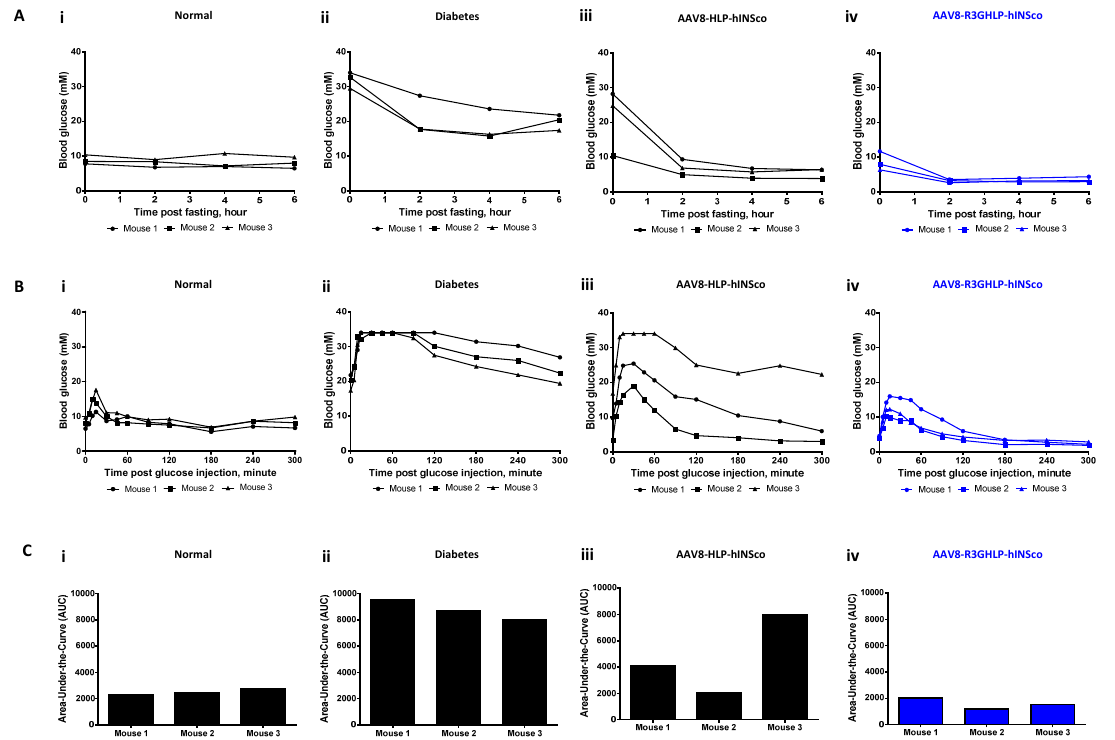
Figure 4. Fasting blood glucose and intraperitoneal glucose tolerance test (IPGTT) of STZ-induced diabetic NSG mice treated with optimum dose of AAV8-R3GHLP-hINSco. Comparison of ( A ) fasting blood glucose (performed at day 73 post AAV8 injection) and ( B ) IPGTT (performed at day 92 post AAV8 injection) for ( i ) normal mice, ( ii ) diabetic mice, ( iii ) AAV8-HLP-hINSco (7.5 × 10 9 vg / mouse) treated mice, and ( iv ) AAV8-R3GHLP-hINSco (5 × 10 9 vg / mouse) treated mice. Normal and diabetic mice were included as controls. ( Ci – iv ) Corresponding area-under-the-curve (AUC) of IPGTT. Data points of individual mouse were shown. n = 3.